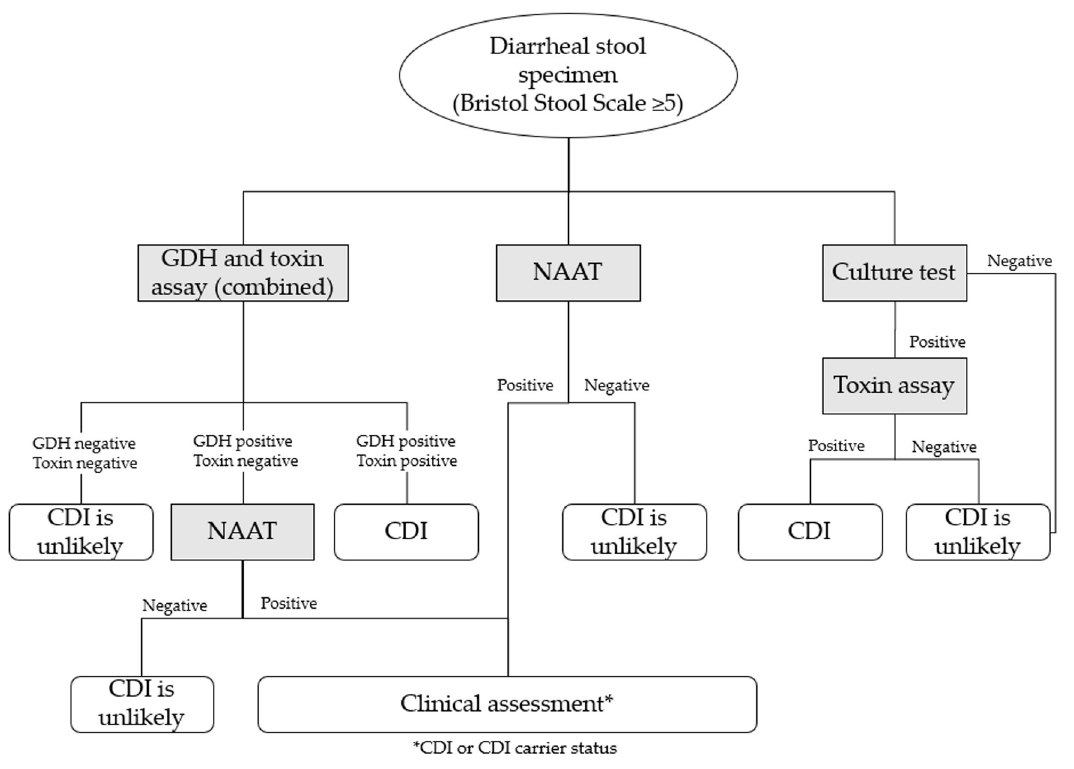
Figure 1. Revised Clostridioides di ffi cile infection diagnostic pathway in Japan. CDI: Clostridioides dif- Figure fi cile infection; GDH: Glutamate Dehydrogenase; NAAT: Nucleic Acid Ampli fi cation Test.